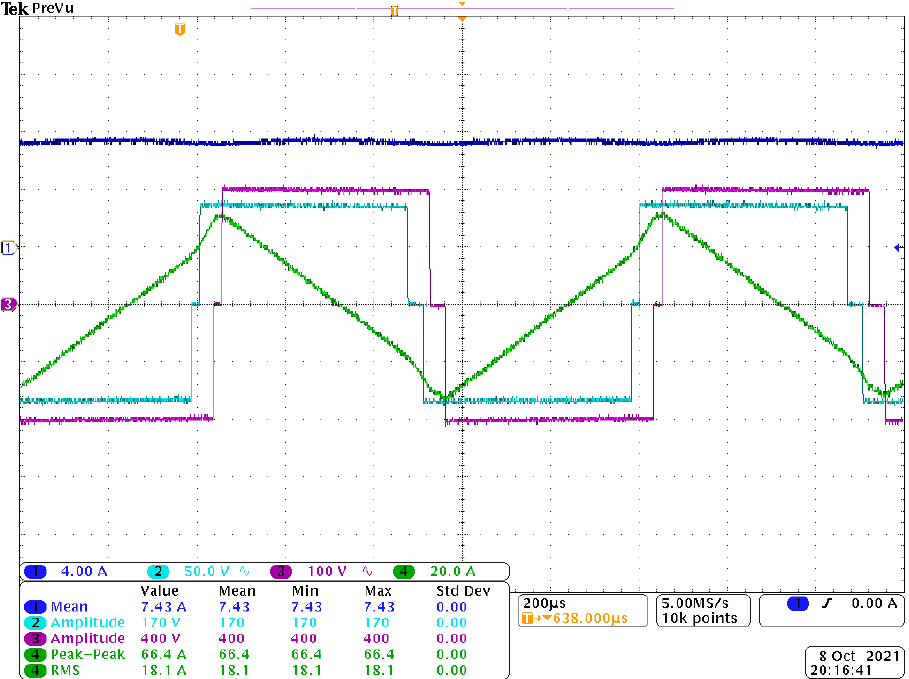
Figure 15. DAB operation at rated power under the DPS